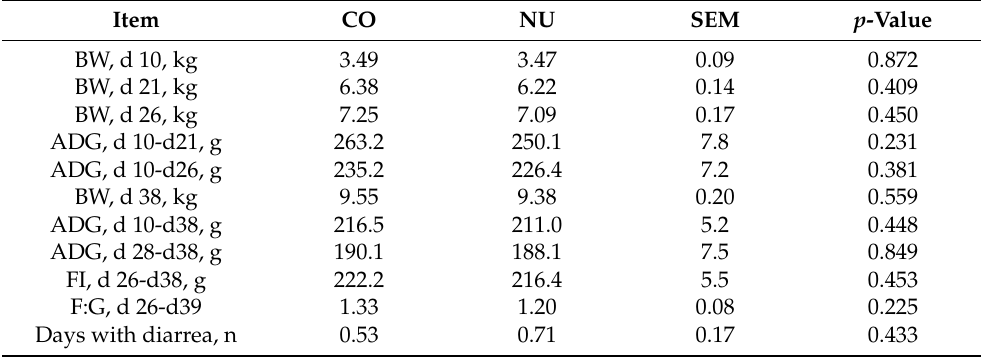
Table 2. Performance data (weaning at d 26; CO = control group; NU = nucleotides group; BW = body